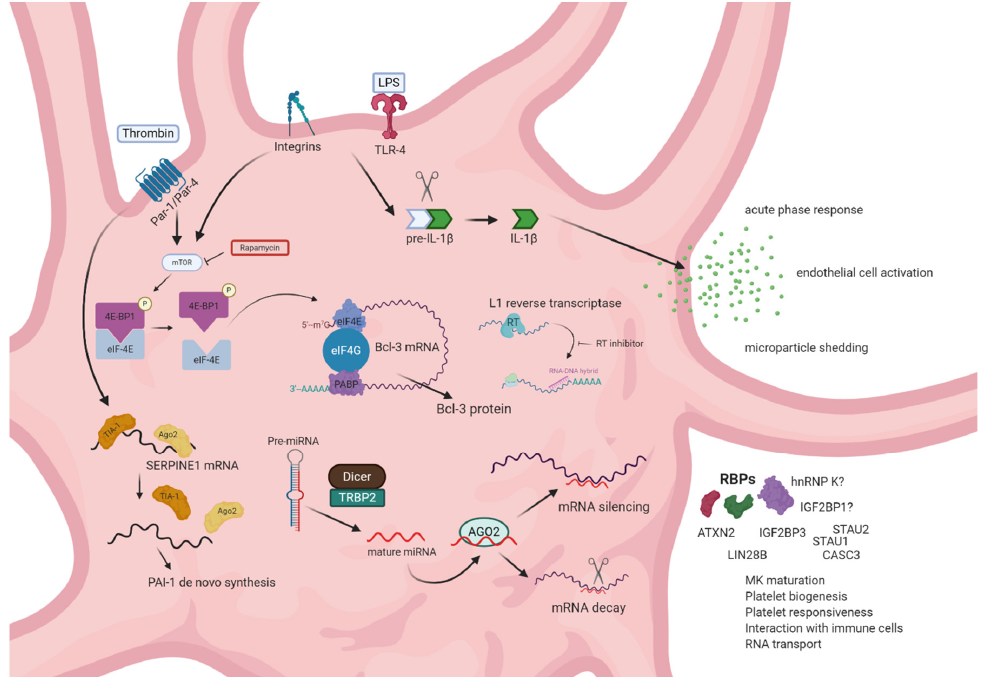
Figure 2. Posttranscriptional gene expression control in platelets. Receptor-mediated signaling may lead to splicing and translational events that are silenced in resting platelets. Lipopolysaccharide (LPS) bindingtotoll-likereceptor4(TLR4)andintegrinsignalinginducestheproteolyticprocessingof pre-IL-1